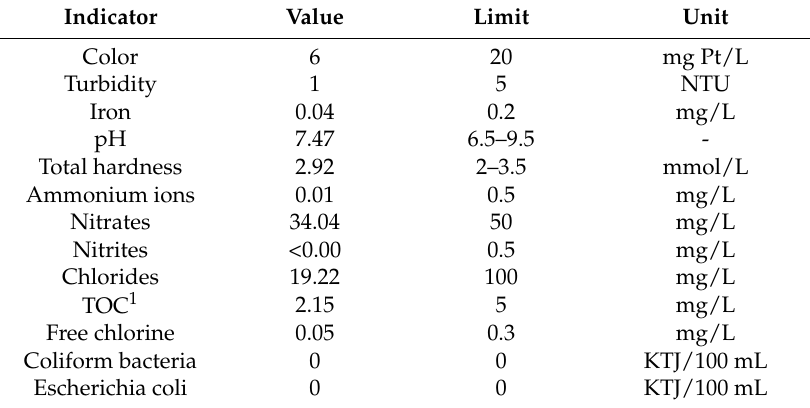
Table 1. The chemical composition of the potable water used in the experiment (before the treatment with the Aqua Osmotic system).